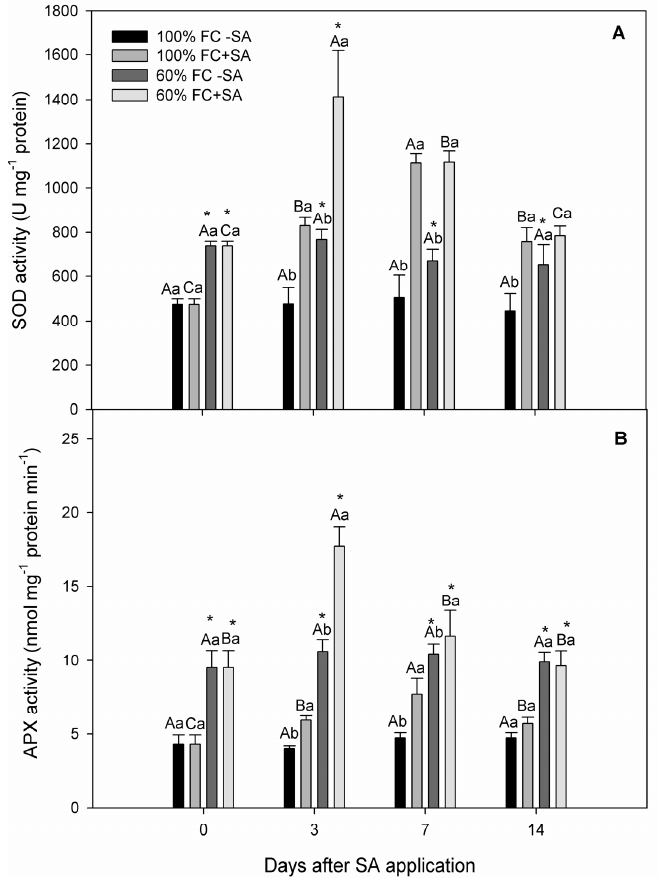
Figure 5. Enzymatic antioxidant system in A. chilensis plants grown under 100% and 60% FC and two SA doses (0 and 0.5 mM) at different times after SA application. ( A ) Superoxide dismutase (SOD) and ( B ) ascorbate peroxidase (APX) activity. The bars are means ± SE ( n = 3). Different up- percase letters indicate significant differences among times post SA application for the same SA and irrigation treatment according to Tukey’s test ( p ≤ 0.05). Different lowercase letters indicate significant differences between SA treatment for the same irrigation treatment and time post SA application according to Tukey’s test ( p ≤ 0.05). According to Tukey’s test, asterisks indicate signif- icant differences between irrigation treatments of the experiment for the same SA treatment and time post SA application ( p ≤ 0.05).